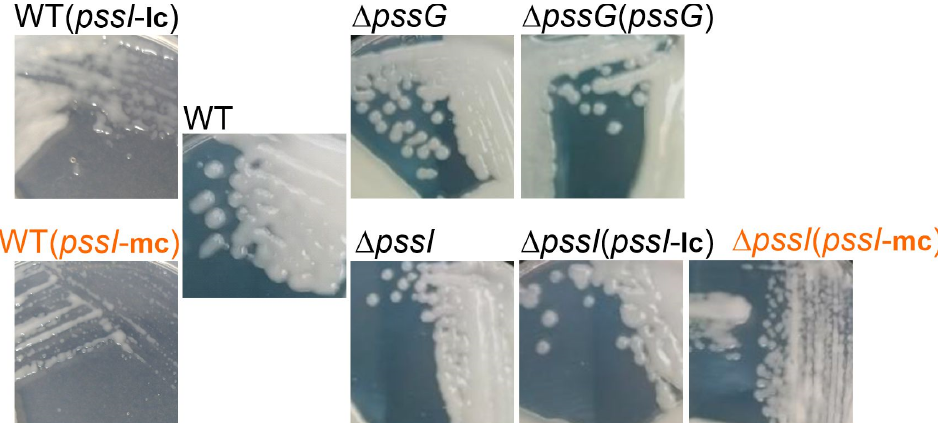
Figure 9. Macroscopic morphology of RtTA1 deletion mutants for the pssG and pssI genes, their derivatives after genetic complementation, as well as the wild ‐ type strain carrying the same complementation plasmids. mc, medium copy number plasmid pBBRMCS ‐ 2 carrying pssI gene; lc, low copy number plasmid pRK7813 carrying pssI gene. Complementation of Δ pssG was performed only with pBBRMCS ‐ 2 derivative plasmid. Names in orange indicate strains where EPS production suppression was visible. All the photographs were taken 5 days post ‐ inoculation.